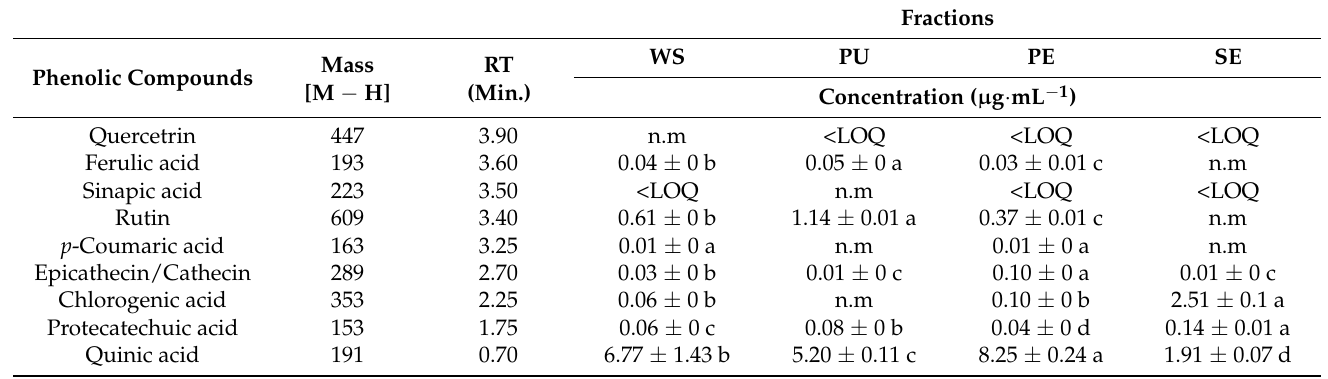
Table 3. Phenolic compounds found by UHPLC-ESI-MS in the buritirana fruit fractions.